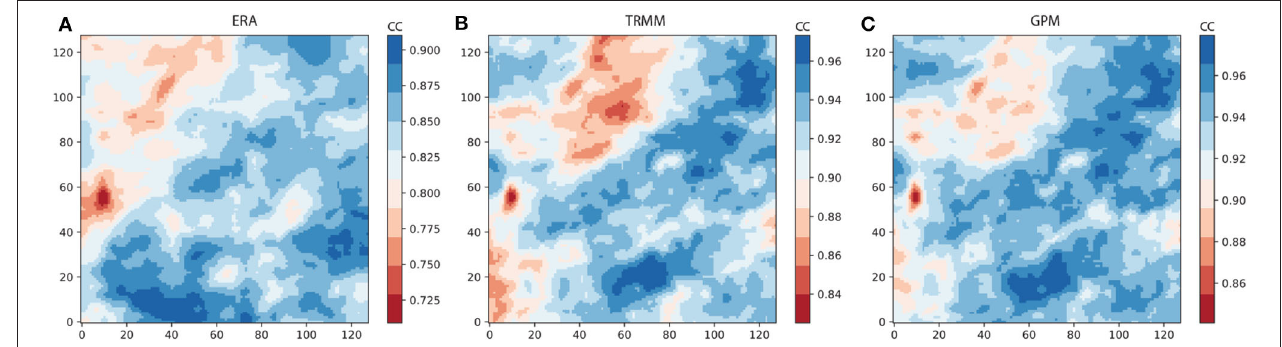
FIGURE 4 | Convergence history of AU-Net training and validation: (A) ERA5, (B) TRMM, and (C) GPM.